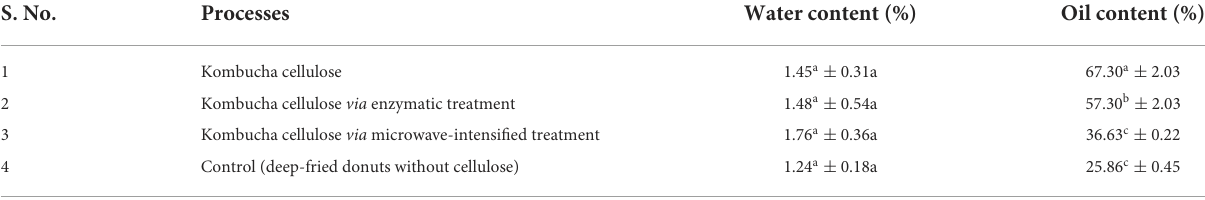
TABLE 3 Water content and oil content of deep-fried donut crusts made using different processes. S. No.